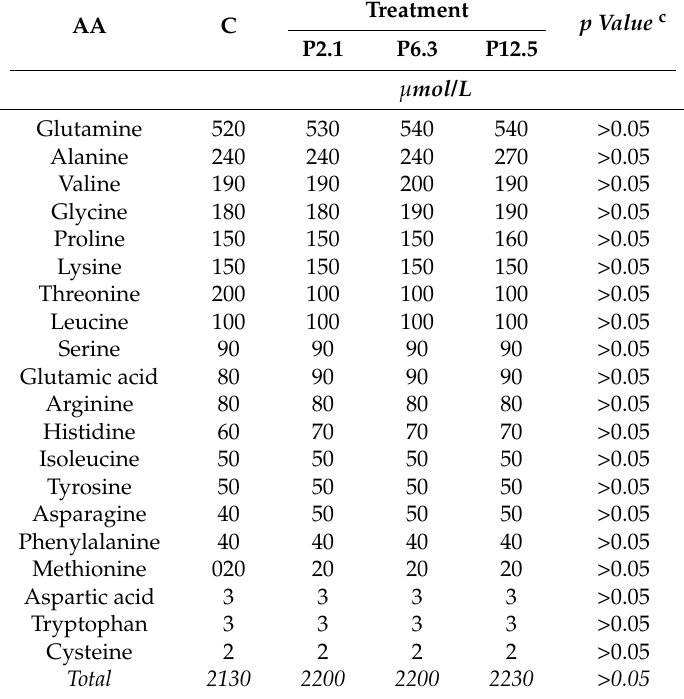
Table 2. Plasma amino acid (AA) concentrations at baseline prior to commencing each infusion a,b,c . AA C